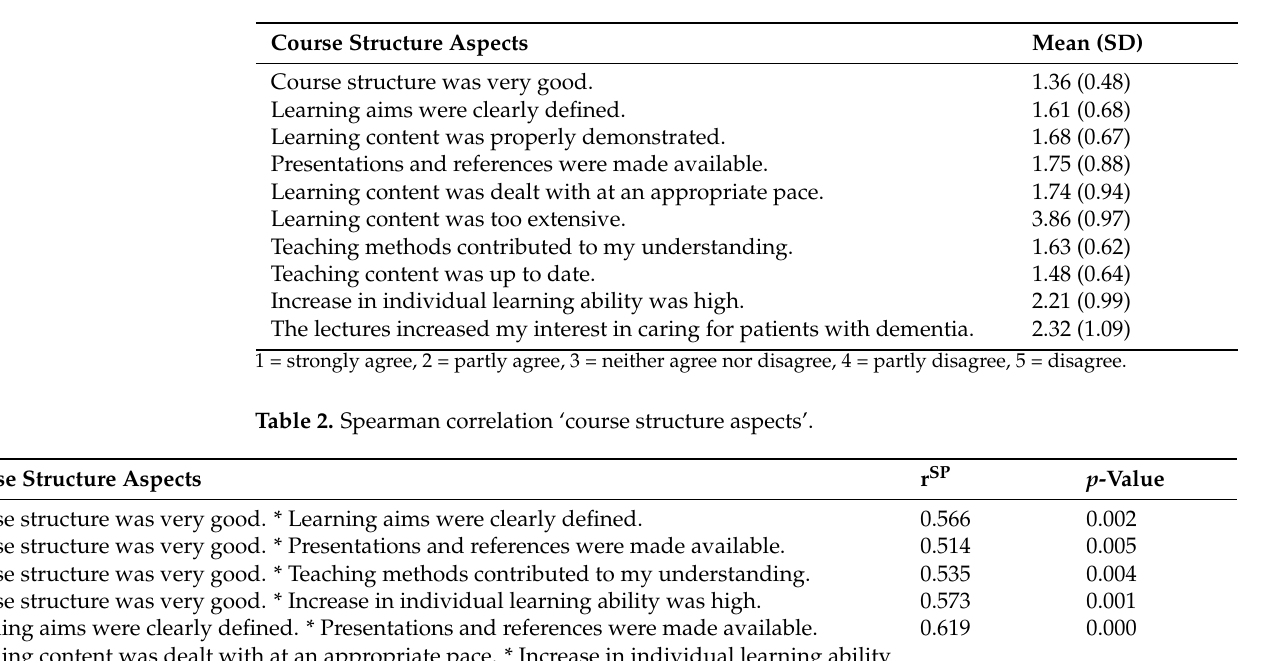
Table 1. Evaluation of the course structure.